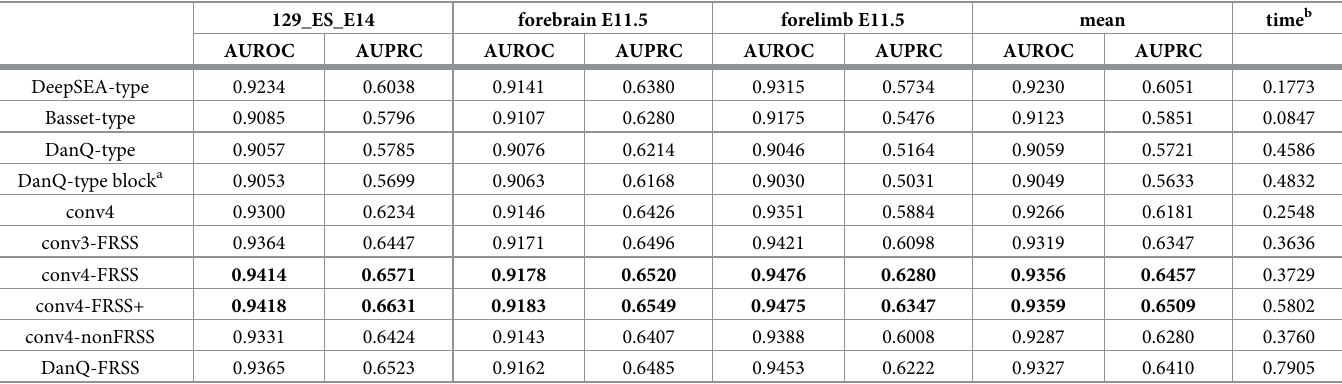
Table 1. A performance comparison between